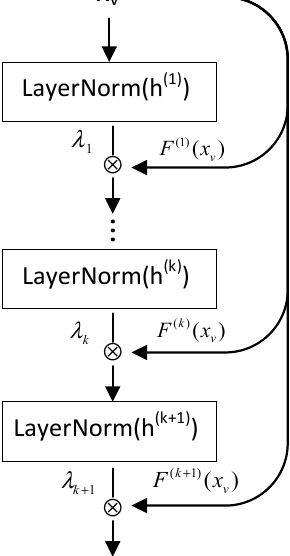
Figure 5. Feedback network architecture.